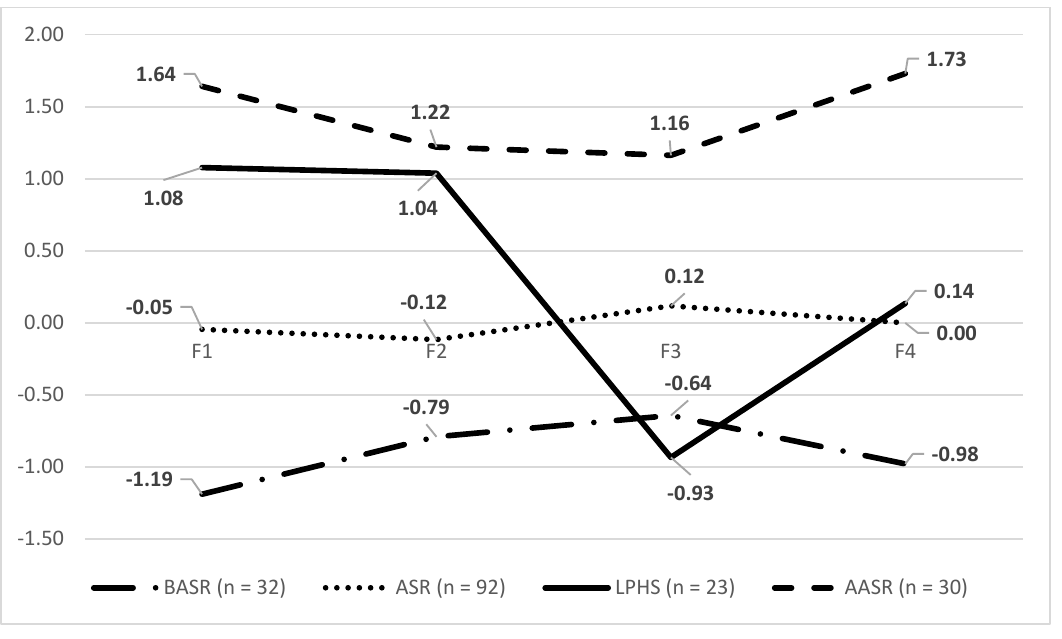
Mean Factor Scores by Latent Profile